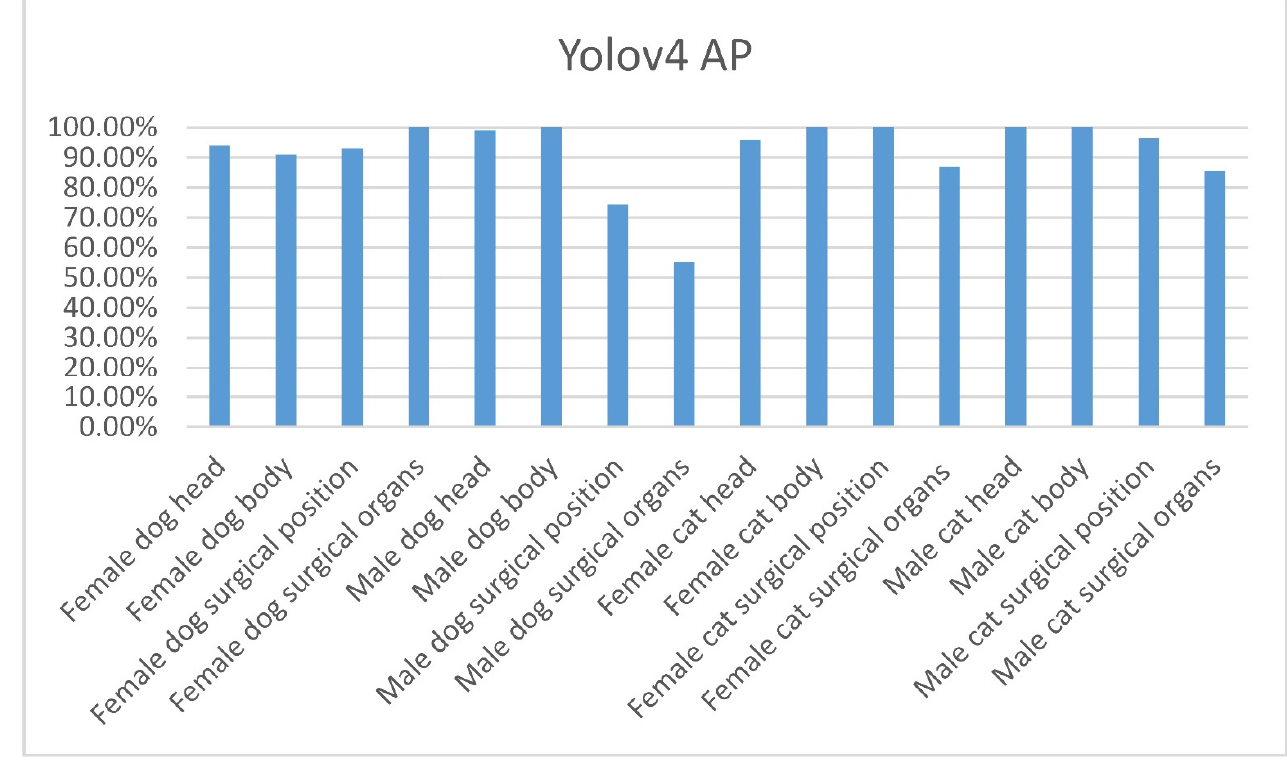
Figure 14. Yolov4 AP of each category.